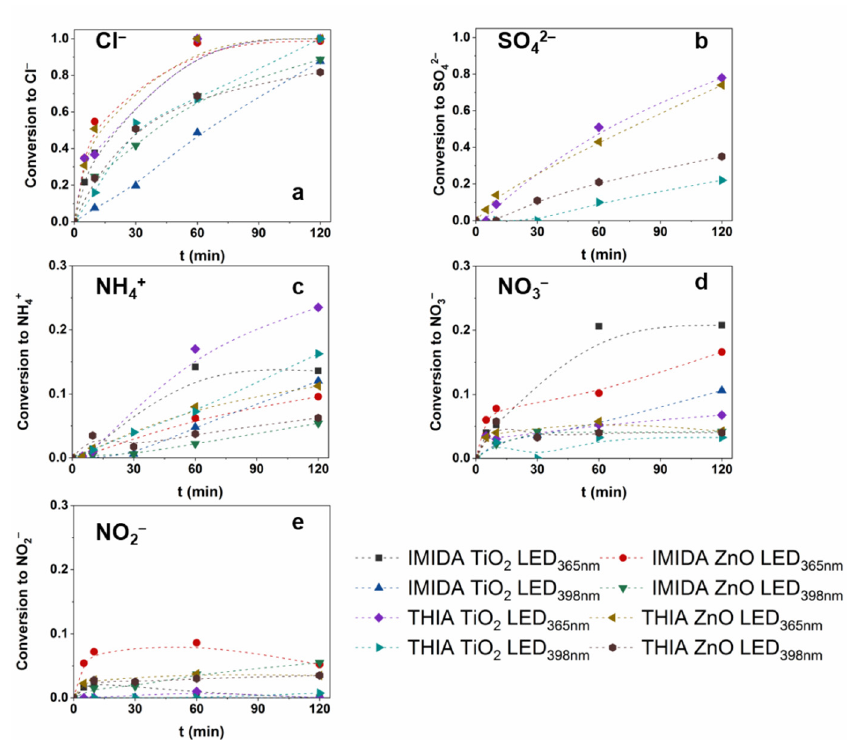
Figure 7. The conversion of organic Cl-, S-, and N-content of IMIDA and THIA to Cl − ( a ), SO 42 − ( b ), NH 4+ ( c ), NO 3 − ( d ) and NO 2 − ( e ).